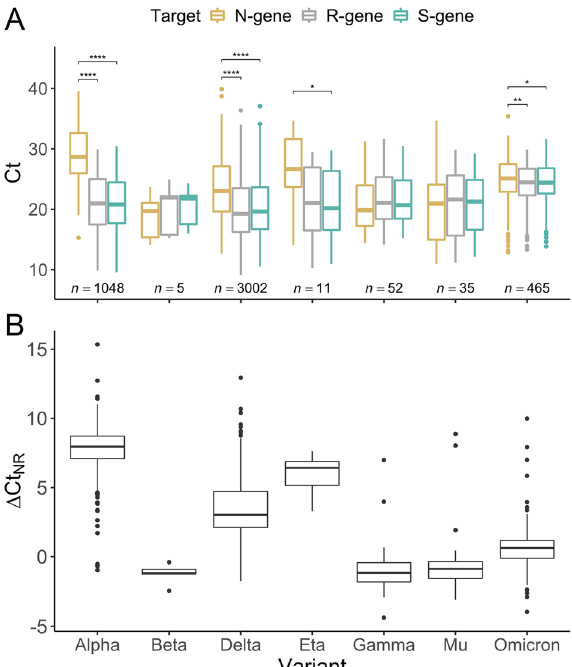
Figure 1. Characteristic RT-PCR profiles identify multiple SARS-CoV-2 variants. ( A ) Ct distributions for each gene target (N, R and S) for variants Alpha, Beta, Delta, Eta, Gamma, Mu and Omicron. Wilcoxon signed-rank test. *: p -value < 0.05. **: p -value < 0.01. ****: p -value < 0.0001. ( B ) Distributions of differences between Ct N and Ct R (∆Ct NR ) for each